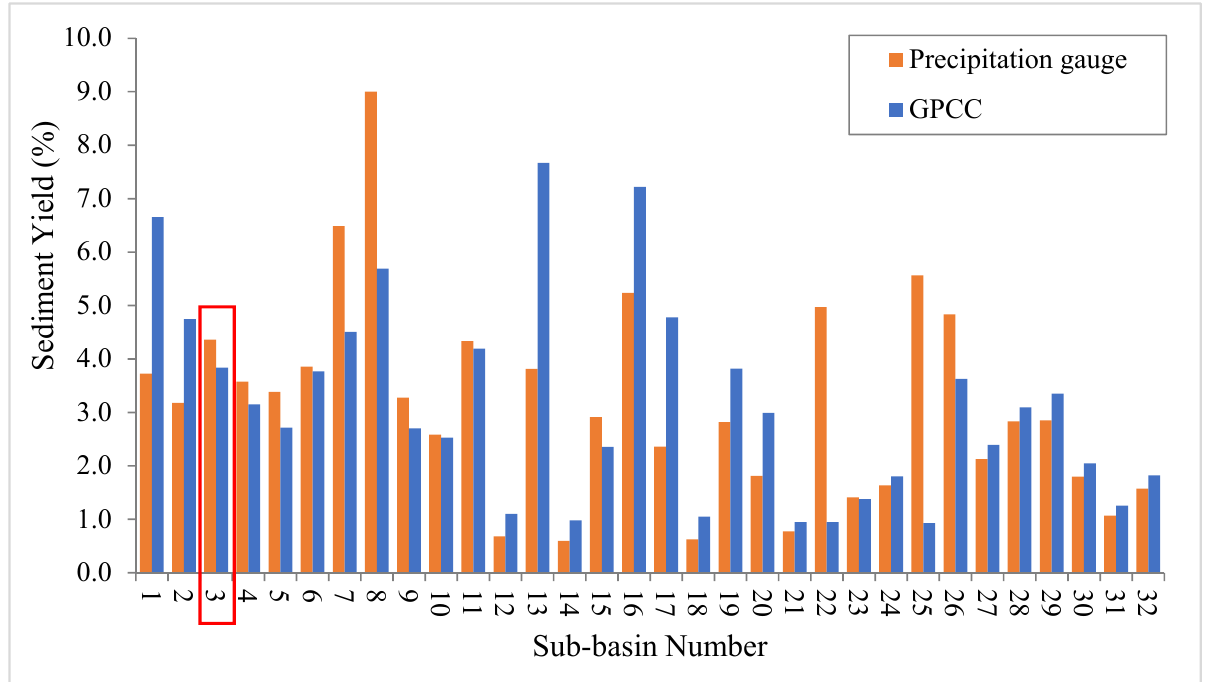
Figure 10. Sediment yield (as percentage of total) from each sub-basin using observed precipitation and the GPCC dataset.